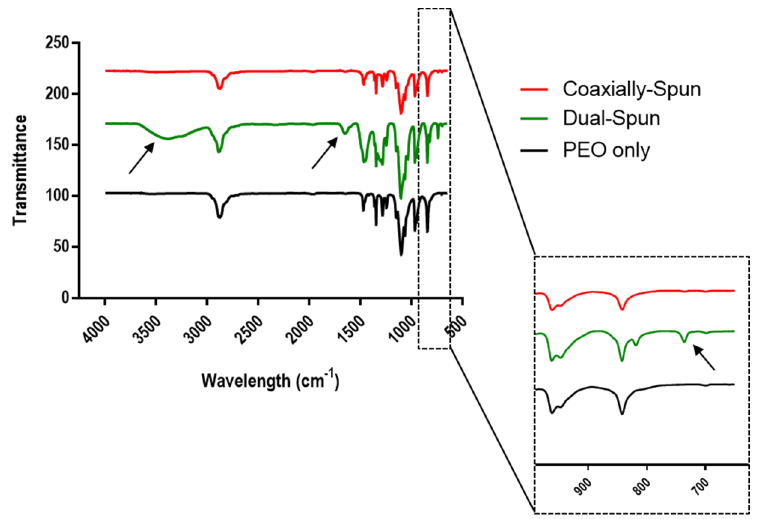
Figure 3. FTIR spectra of electrospun PEO (black), dual-spun PEO/Cerium(III) nitrate (green), and coaxially-spun PEO/Cerium(III) nitrate (red) scaffolds. Arrows indicate known peaks (3387 and 1641 are O-H groups of bound moisture, and ~700 is Ce(III)) [14].